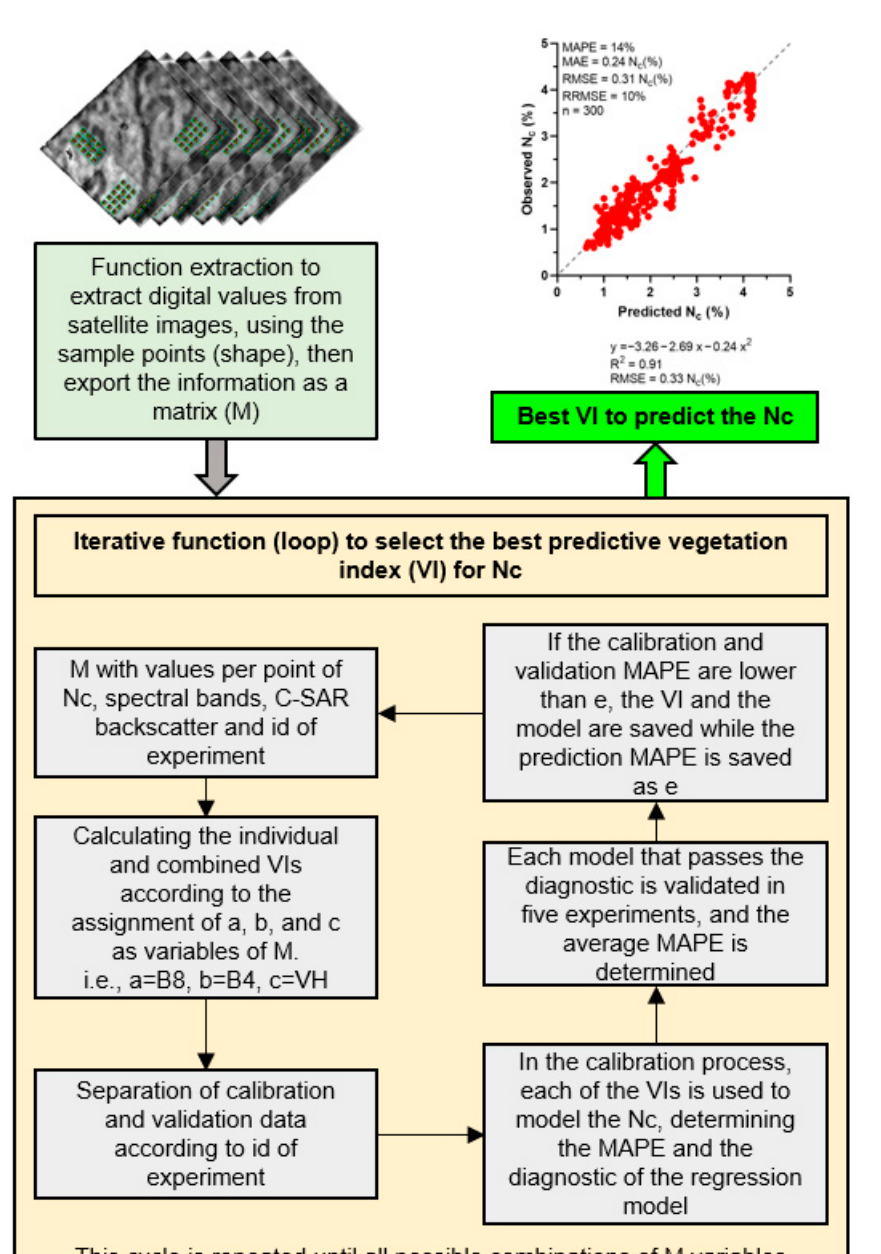
Figure 3. Workflow for selecting the best vegetation index (VI) for modeling and predicting corn plant nitrogen concentration (Nc). MAPE: mean absolute percentage error; e: slightest stored prediction error.